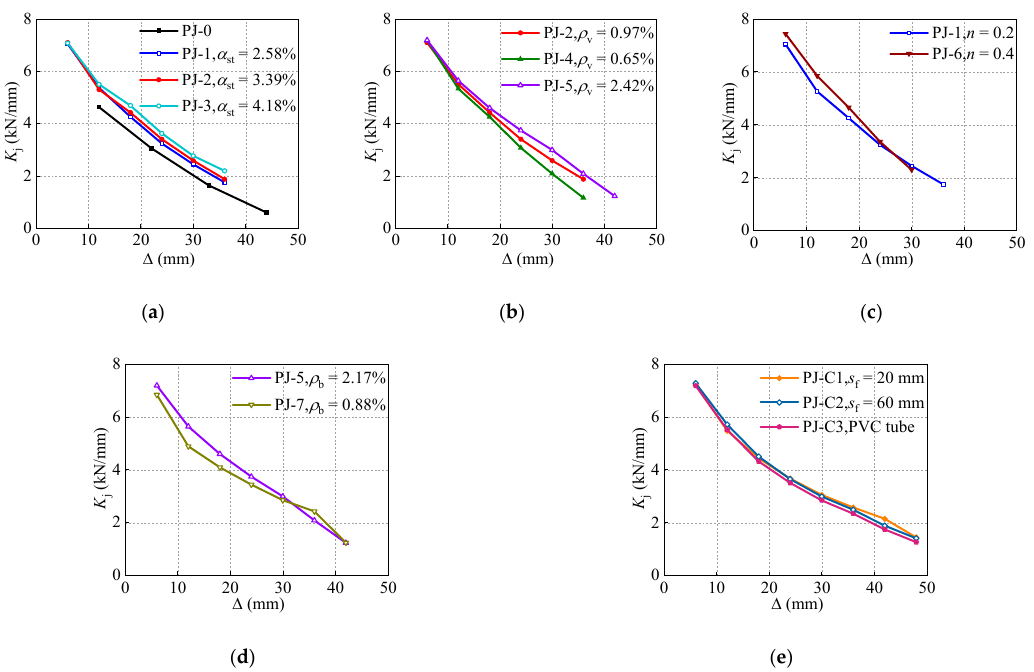
Figure 11. Effects of design parameters on the loop stiffness. ( a ) Steel ratio of STC. ( b ) Stirrup ratio of the joint. ( c ) Axial compression ratio. ( d ) Reinforcement ratio of the frame beam. ( e ) CFRP strips spacing.